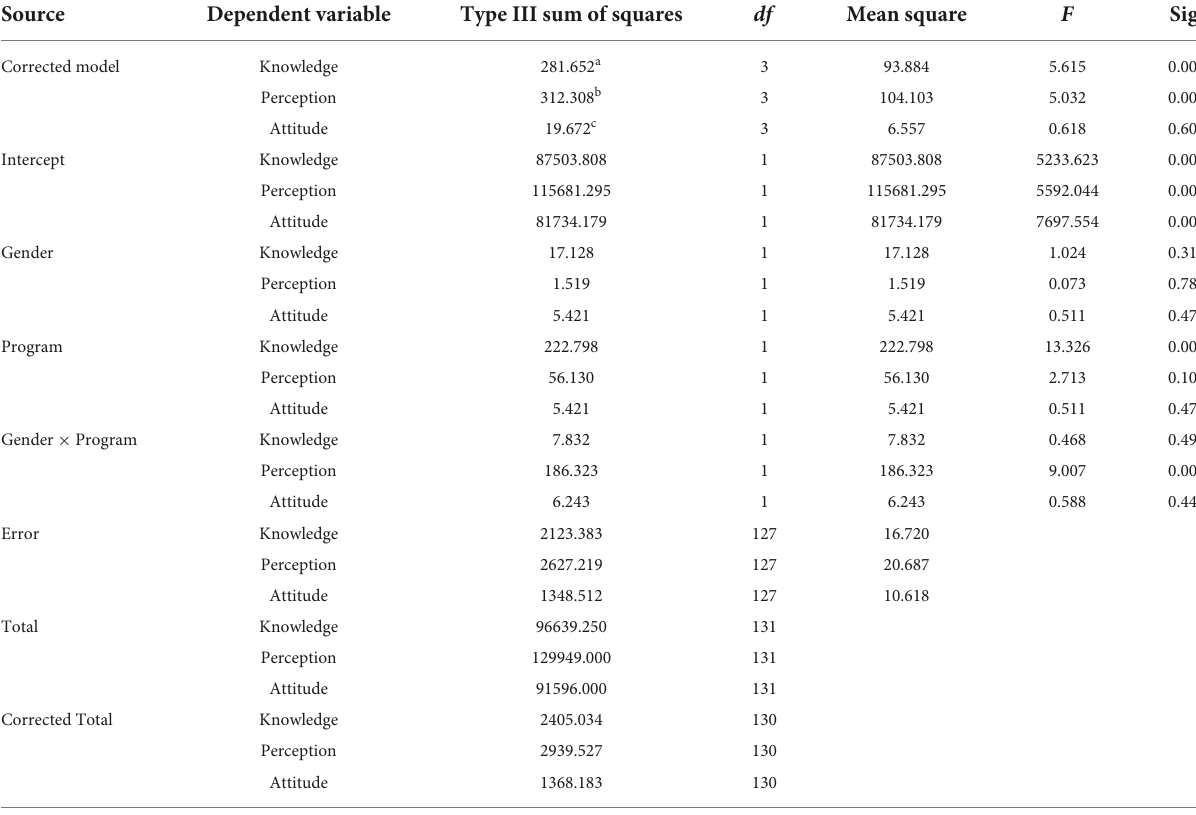
TABLE 3 Tests of between-subjects